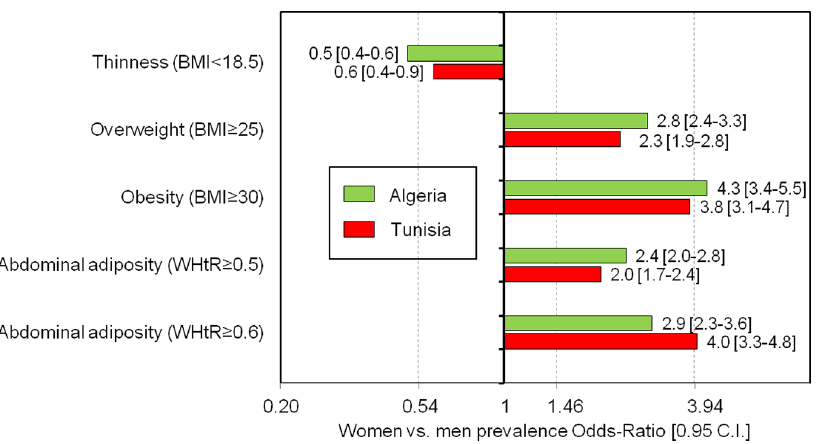
Figure 1. Gender contrasts of overall and abdominal adiposity among Algerian and Tunisian 35–70 year old adults. Women vs. men prevalence proportion odd-ratios weighted estimates for overall and abdominal adiposity, by country (Algeria women: n=2742, men: n=2004; Tunisia women: n=2964, men: n=2379). BMI: Body Mass Index in kg/m 2 , WHtR: Waist (cm) to Height (cm) Ratio. C.I.: 0.95 confidence interval adjusted for sampling design.